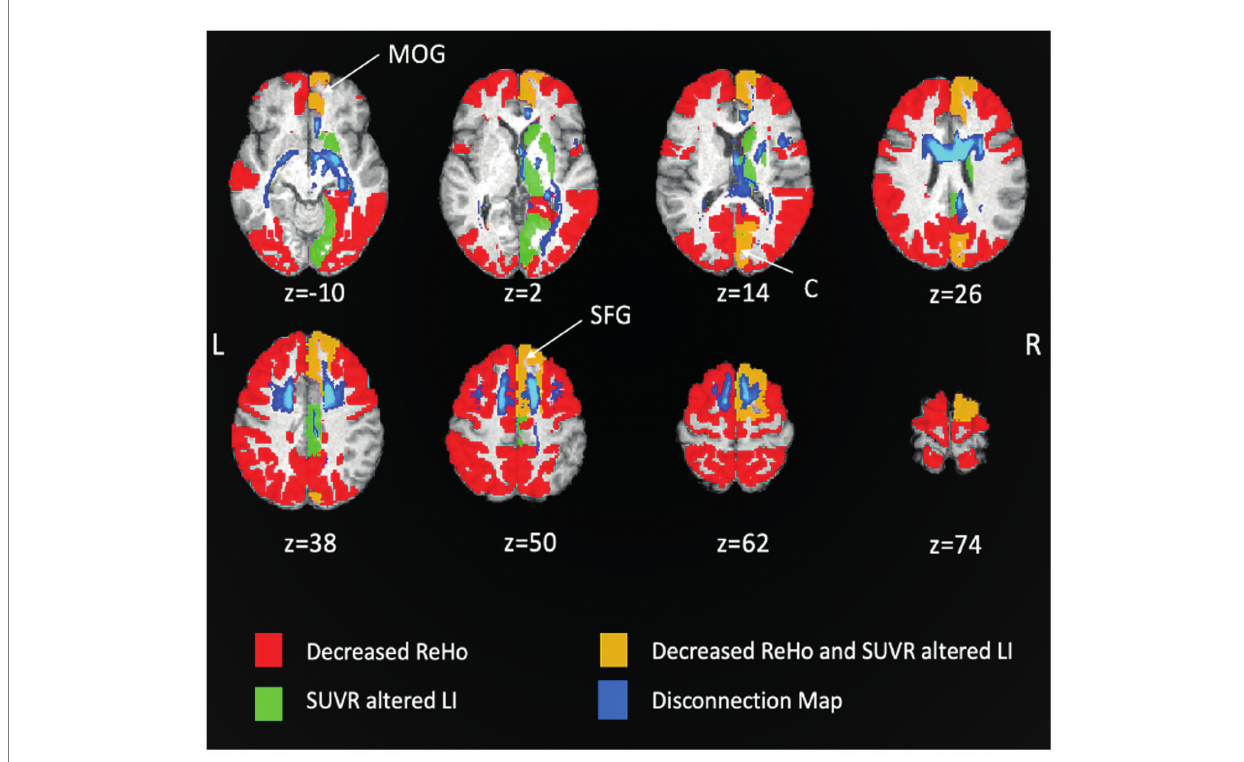
FIGURE 3 Overlap maps of decreased ReHo, [ 18 F]FDG SUVR altered laterality index (LI) and disconnection map. Patient’s regions with decreased ReHo are shown in red, SUVR altered LI in light green. The overlap between decreased ReHo and SUVR altered LI is depicted in orange and corresponds to right medial prefrontal and right medial occipital cortices. The structural disconnection map is shown in blue (MOG, medial orbital gyrus; C, cuneus; SFG, superior frontal